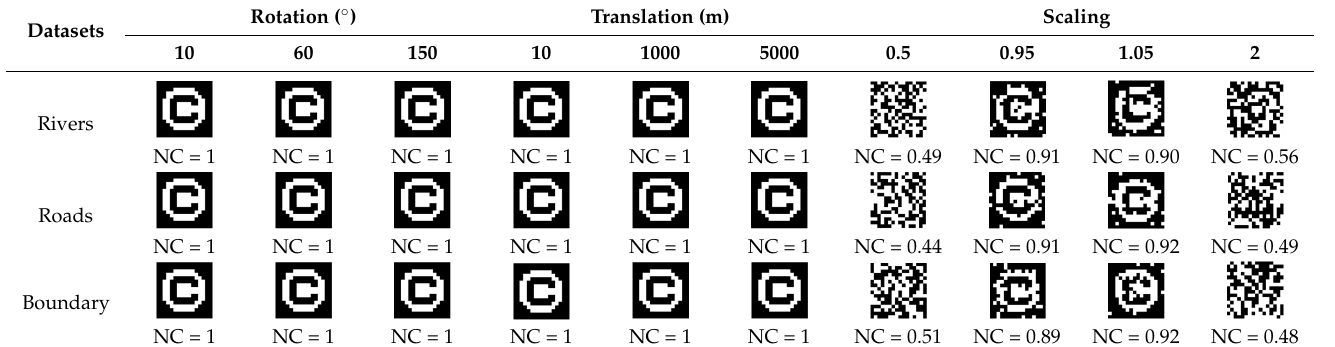
Table 3. The results of RST attacks.